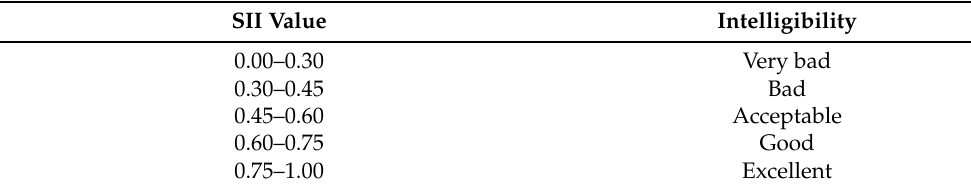
Table 2. Intelligibility scale according to SII